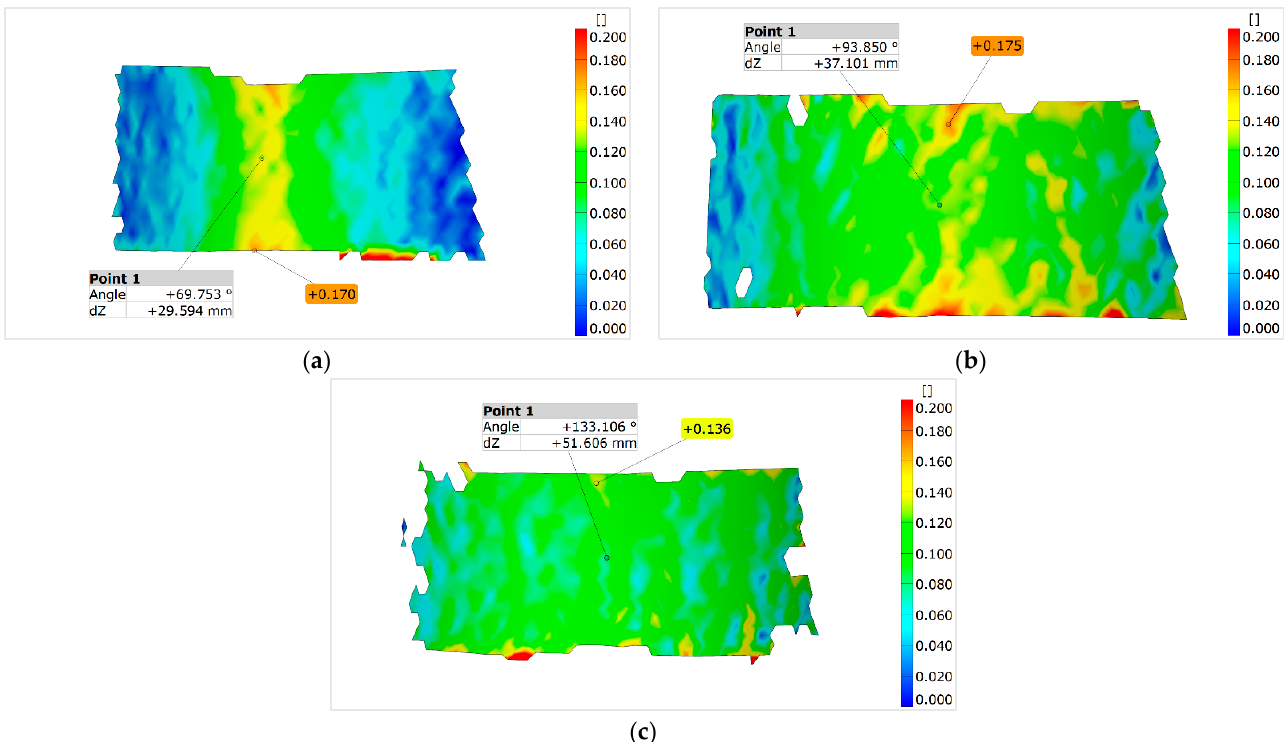
Figure 11. True strain field before fracture initiation of 4.5 mm test specimens; ( a ) R10; ( b ) R15; ( c ) R20.